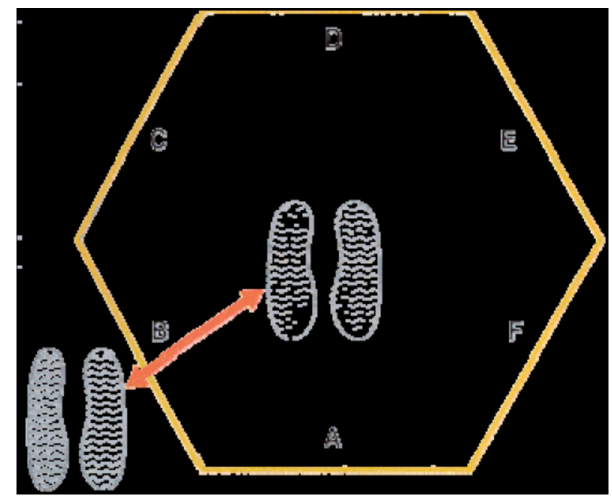
Figure 1. Hexagonal test obstacle.